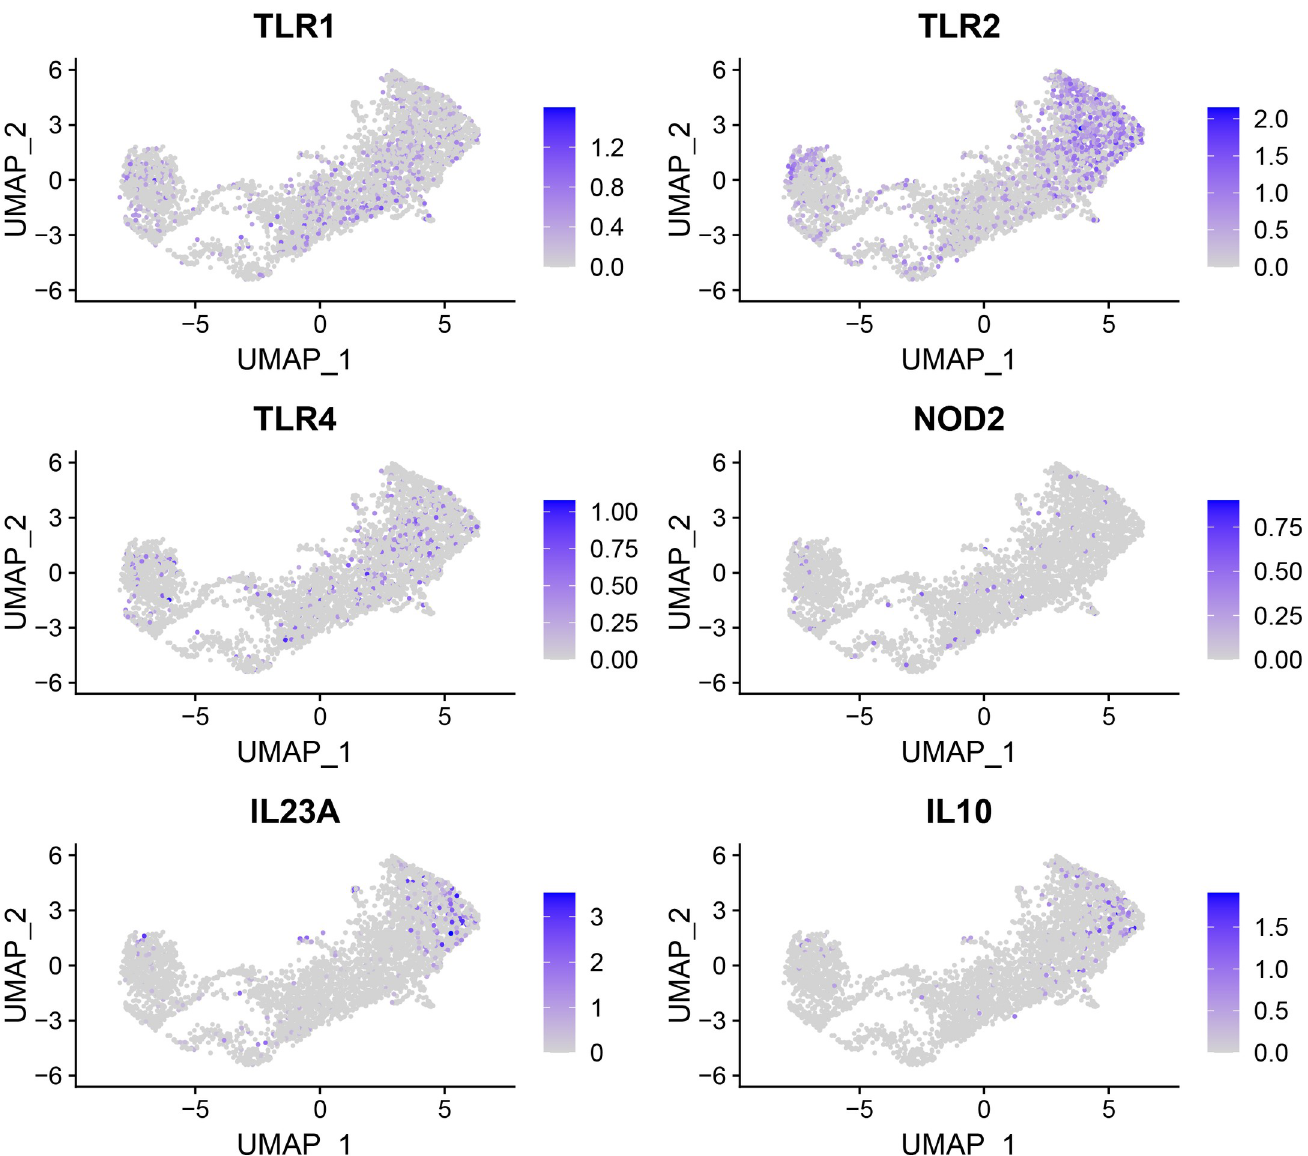
Fig 3. Expression of pattern recognition receptor and cytokine genes in single cells. Cells expressing the corresponding gene were colored according to the expression level (log scale).